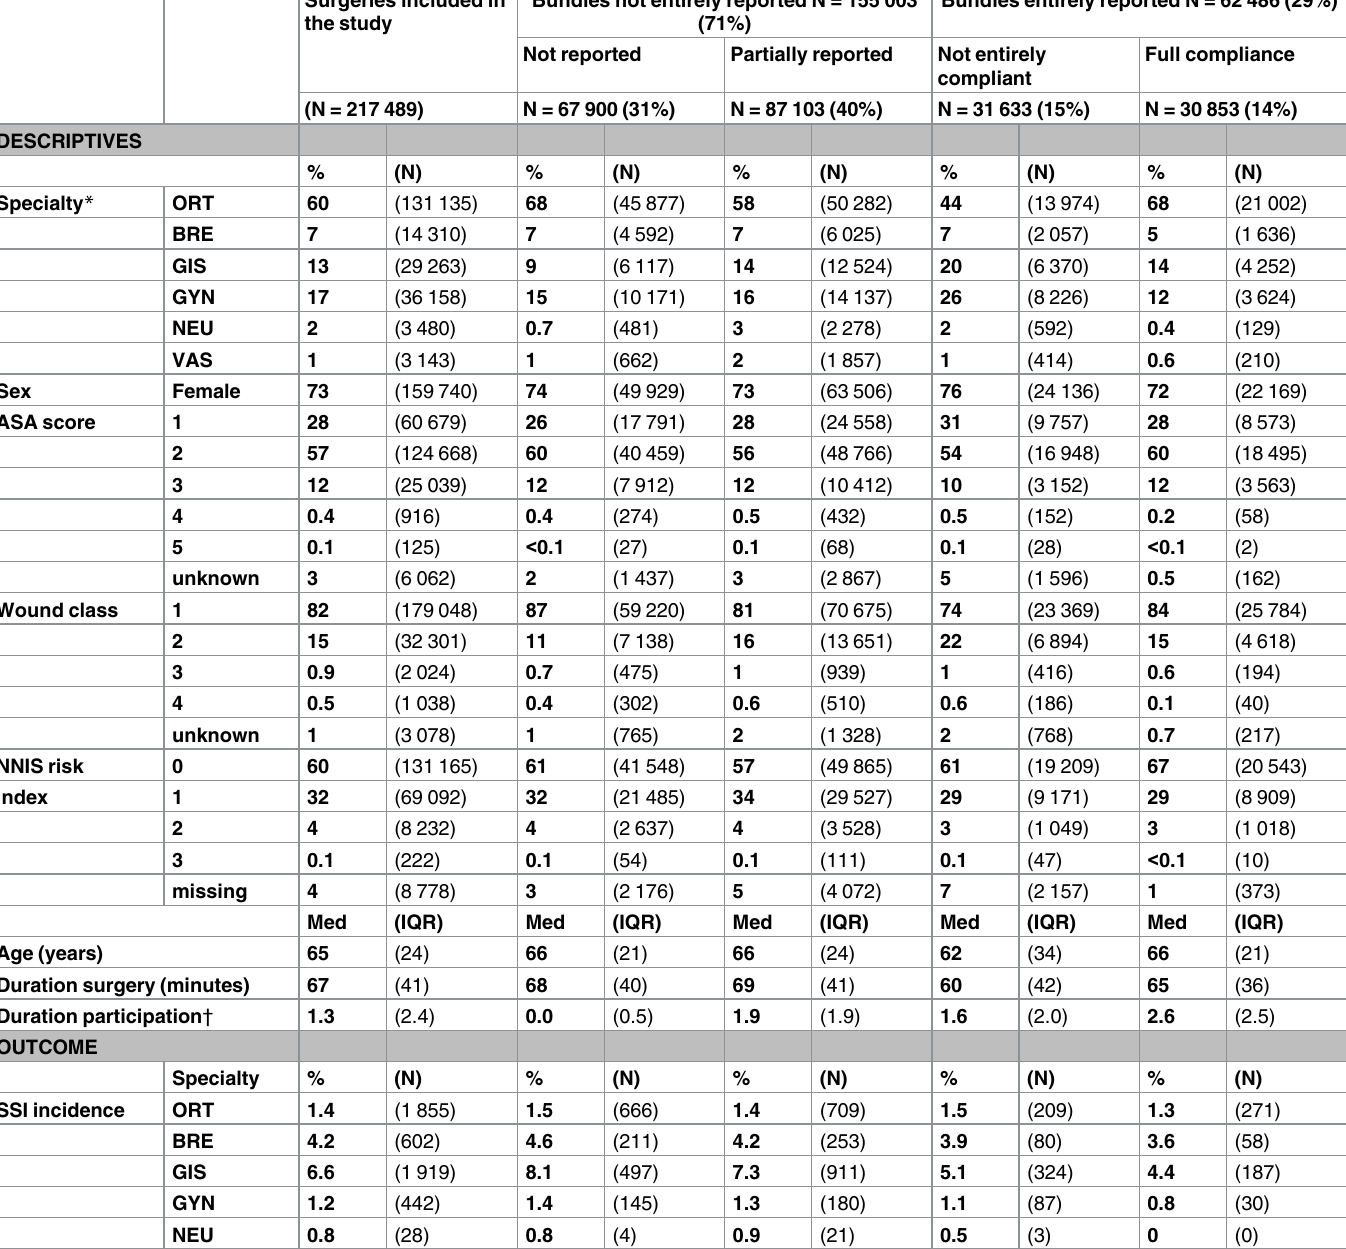
Table 3. Baseline characteristics of surgeries with bundles not reported, partially reported, entirely reported but not fully compliant, and entirely reported with full